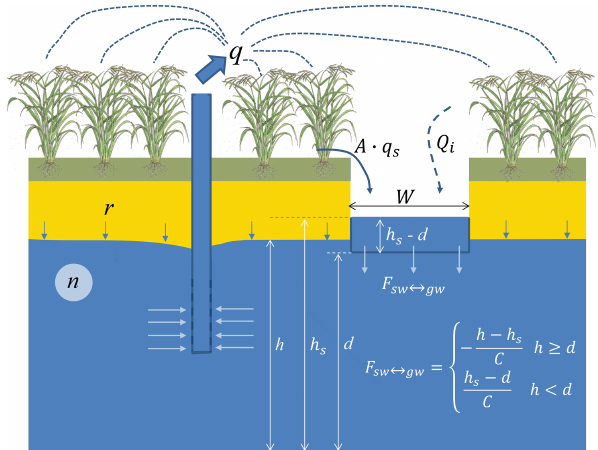
Figure 2. Conceptual model of groundwater extracted (in this case for irrigation) from an aquifer recharged by diffuse recharge and riverbed infiltration. Symbols are explained in the